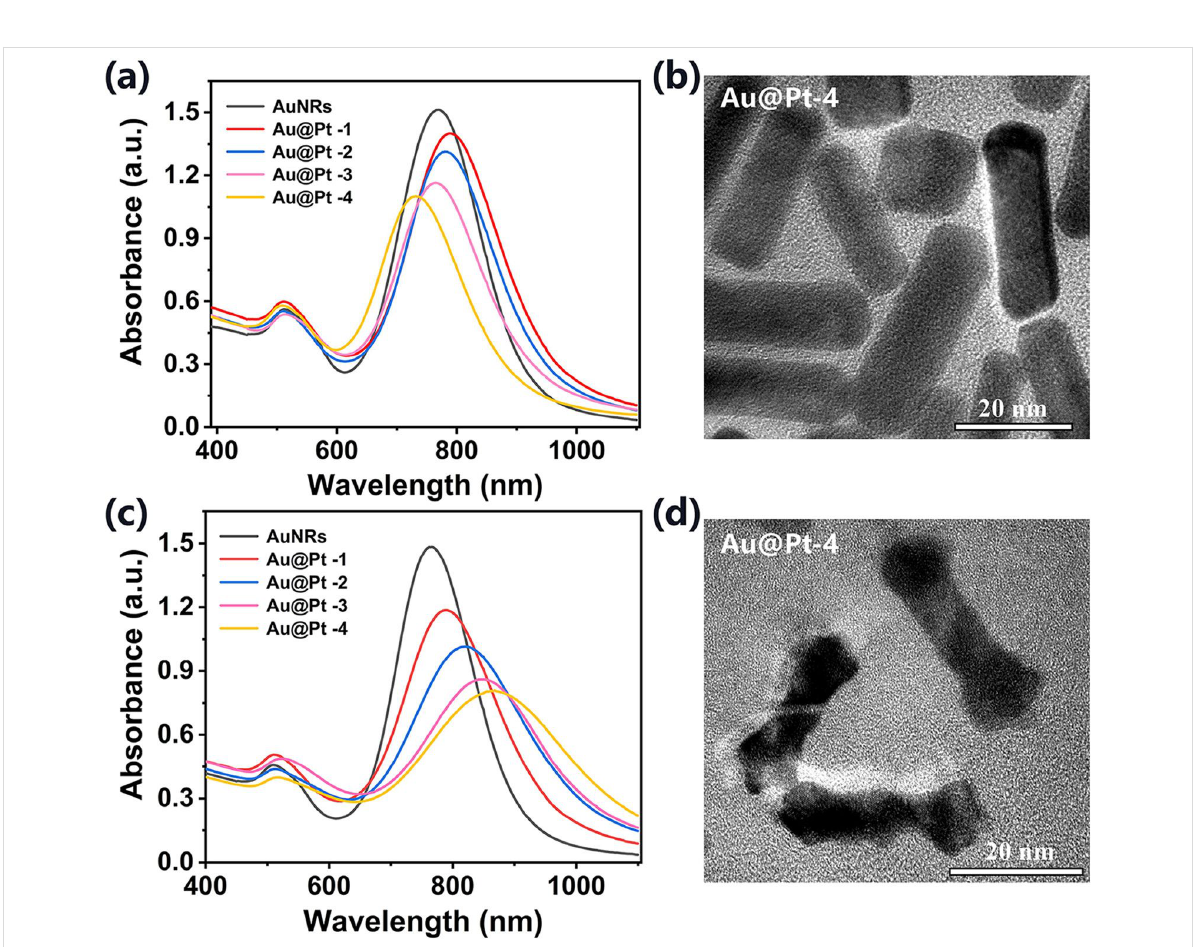
Figure 3: Absorption spectra of AuNRs and of different Au@Pt NRs synthesized in (a) absence and (c) presence of Ag + . (b) and (d) are TEM images of Au@Pt-4 in (a) and (c), respectively. Annotation: Au@Pt-1, Au@Pt-2, Au@Pt-3, and Au@Pt-4 represent the Au@Pt NRs prepared with different concentrations of added K 2 PtCl 4 : 5, 10, 20, and 40 mM,